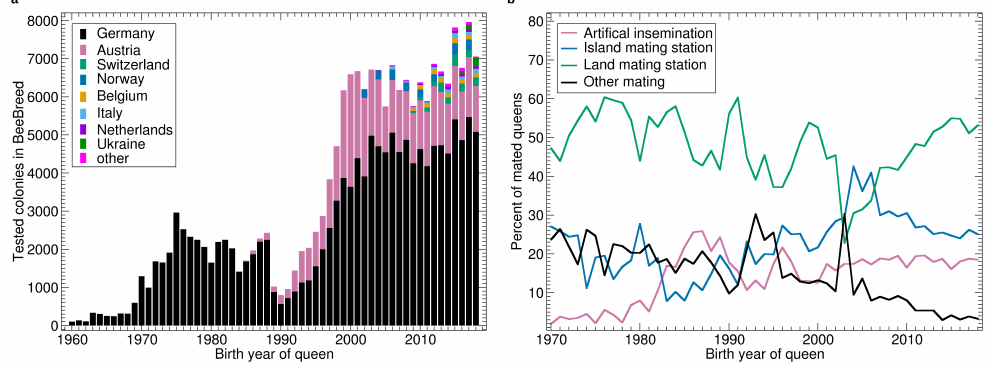
Figure 1. ( a ) Number of tested colonies by year, bars stacked by country. ( b ) Percentage of queens with different types of mating. The category “other mating” refers to race mating stations, apiary mating or unknown paternal